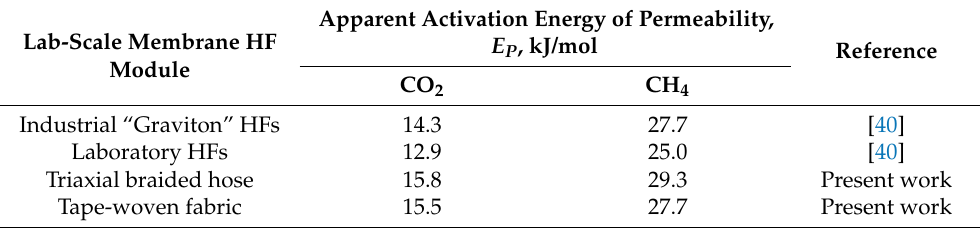
Table 4. Apparent activation energies of the gas permeability for different lab-scale membrane